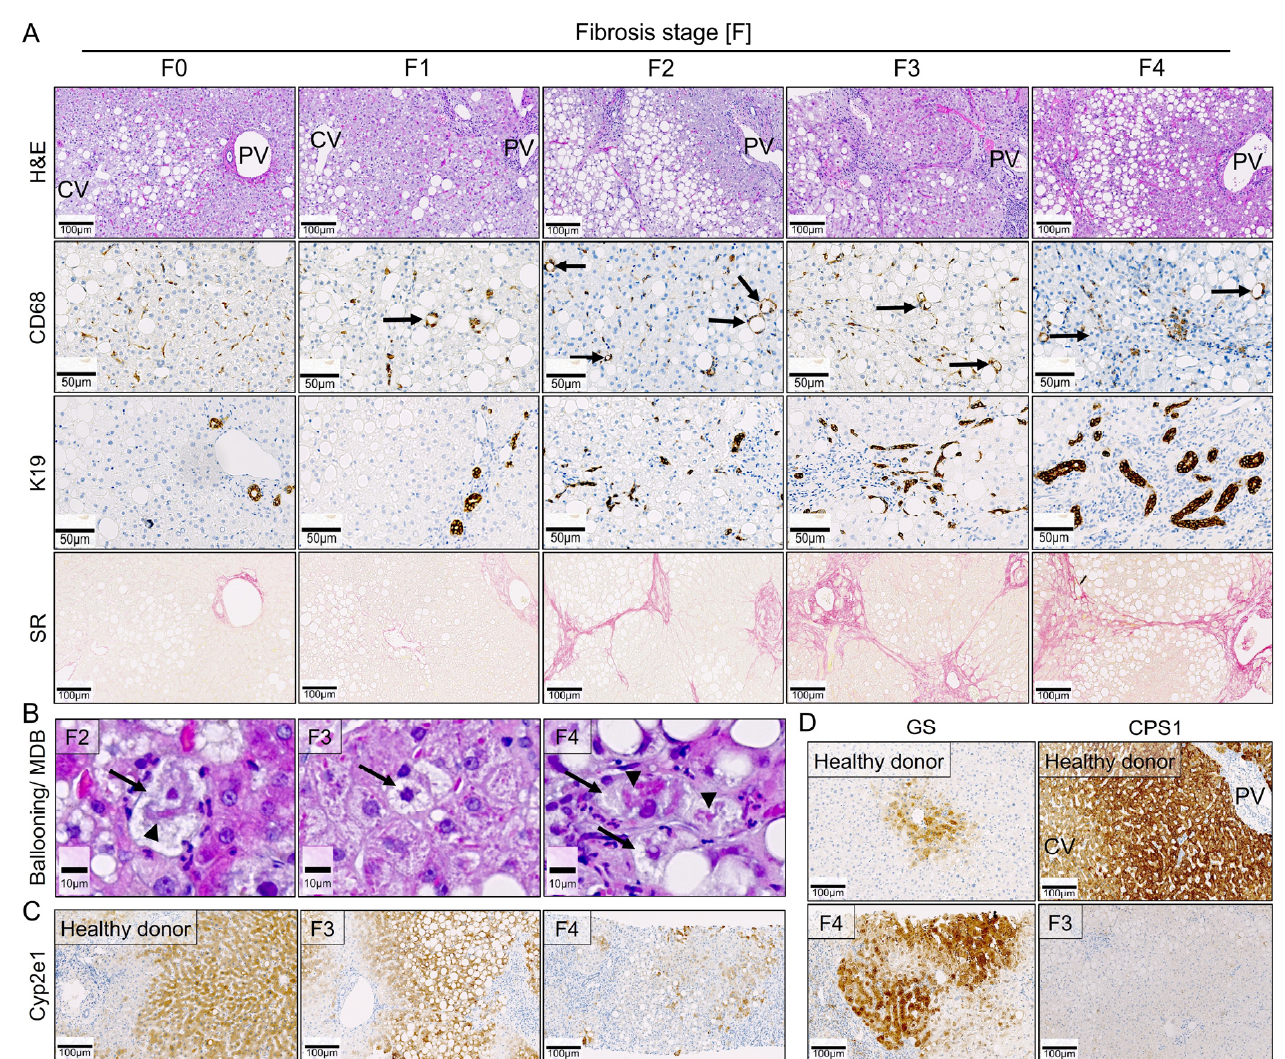
Figure 8. Comparison of the key features identified in the Western diet mice to NAFLD patients. ( A ) H&E staining (scale bars: 100 µ m), lipogranulomas (CD68; scale bars: 50 µ m) as identified with arrows, ductular reaction (K19; scale bars: 50 µ m), and Sirius red staining (SR; scale bars: 100 µ m) in NAFLD patients of all fibrosis stages (F0–F4). ( B ) Hepatocellular ballooning (arrows) and Mallory–Denk bodies (arrowheads, MDB) in F2–F4 patients; scale bars: 10 µ m. ( C ) Reduced Cyp2e1 expression in F3 and F4 patients. Note, the lobular reorganization as highlighted by patchy periportal Cyp2e1 expression in F4 patients; scale bars: 100 µ m. ( D ) Increase an abnormal periseptal localization of glutamine synthetase (GS) expression and decrease in carbamoyl-phosphate synthase 1 (CPS1) in NAFLD liver tissue with advanced fibrosis; scale bars: 100 µ m. Abbreviations: CV, central vein; PV, portal vein; F3: fibrosis stage 3; F4: fibrosis stage